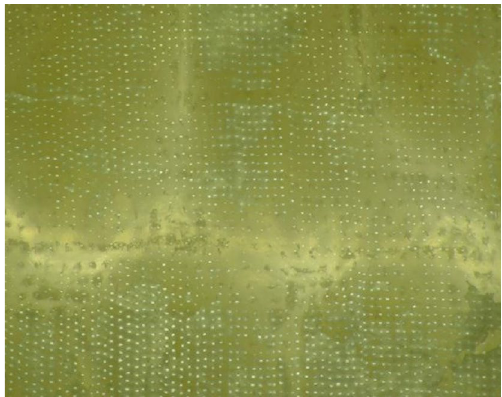
Figure 3. Low magnification optical microscope image to evaluate the efficiency of poration in a P sample. The presence of pores in the entire surface was confirmed by the greater passage of light through them.